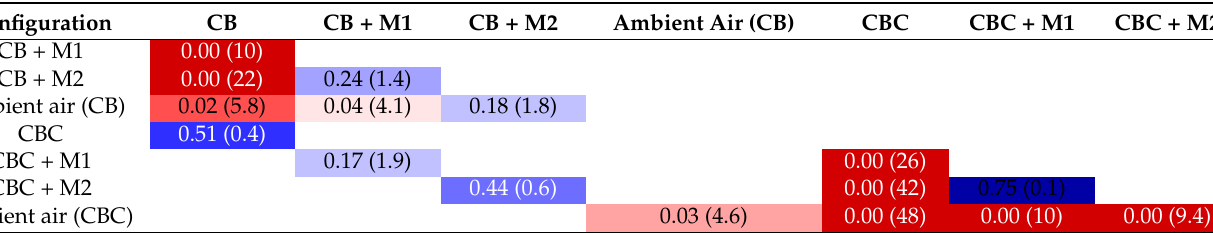
Table 3. Heatmap showing results of the Mood’s median test ( p -values and χ 2 in parenthesis), performed to test the null hypothesis that the medians of two series of bacterial concentration in treated gases/ambient air were identical. Significance level of Pearson’s chi-squared test was α = 0.05, corresponding to χ 2 crit = 3.8. Statistically significant ( p < 0.05, χ 2 > 3.8) differences are highlighted in red. Bed materials: CB—mix of stumpwood chips and pine bark; CBC—mix of stumpwood chips, pine bark, and compost from green waste; CB/CBC + M1/M2—combined biofilter with CB/CBC bed and M1/M2 membrane.